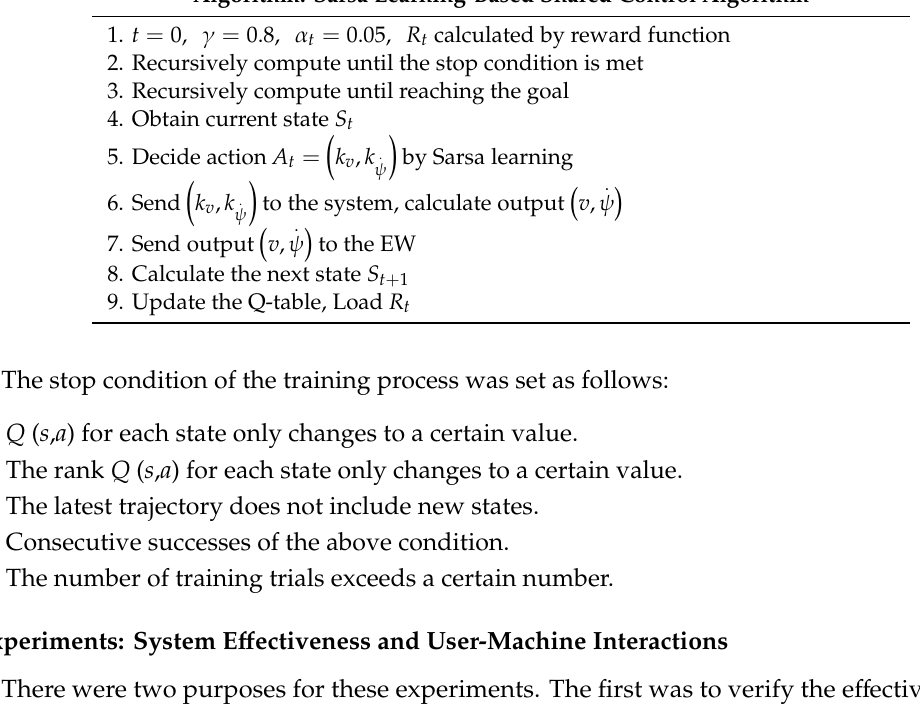
Table 3. Shared control algorithm for EW driving. Algorithm: Sarsa Learning-Based Shared Control